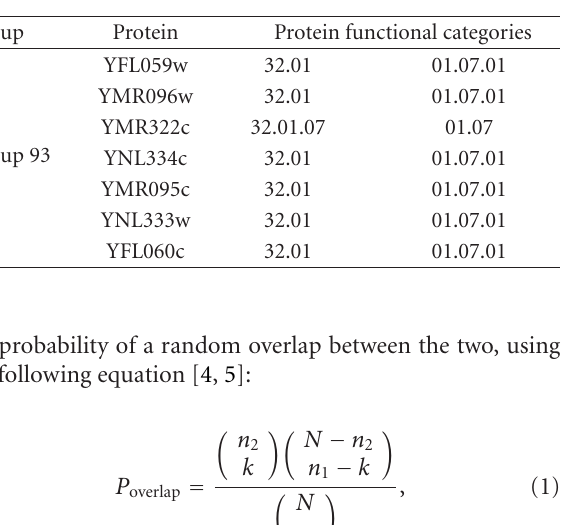
Table 2: Functional annotation of group 93 shown in Figure 5. The code represents functional